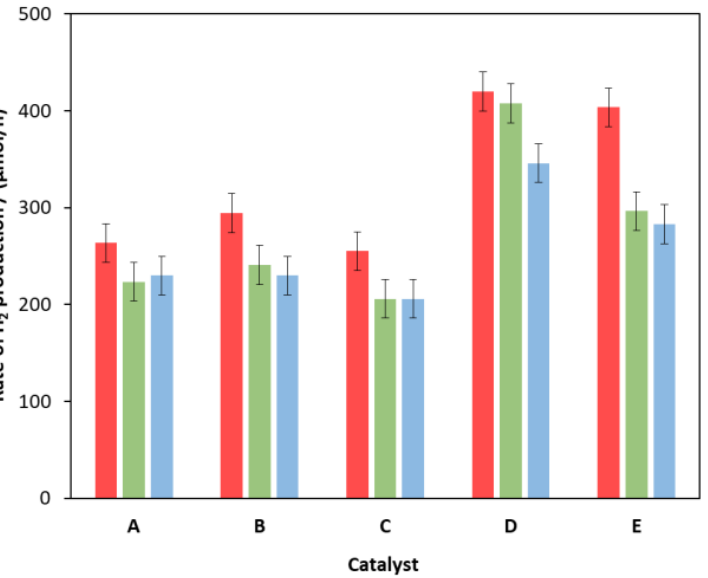
Figure 8. Changes in RHP over 3 consecutive illuminations for some catalysts: hydrothermally treated unmodified ( A ); hydrothermally treated and modified with 0.1% Ni(II) in the bulk ( B ) or on the surface ( C ); hydrothermally untreated and modified with 0.1% ( D ) and 0.3% ( E ) Ni(II) on the